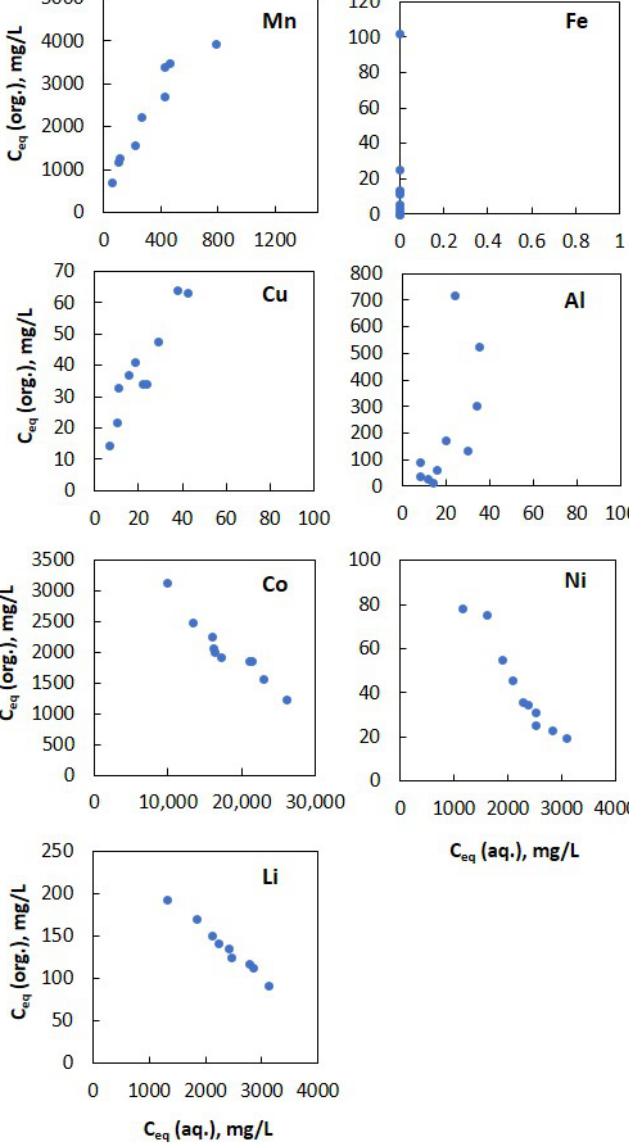
Figure 4. Loading isotherms of Mn, Fe, Cu, Al, Co, Ni and Li in 0.8 M D2EHPA in Exxsol ® D80 ™ at 35 ◦